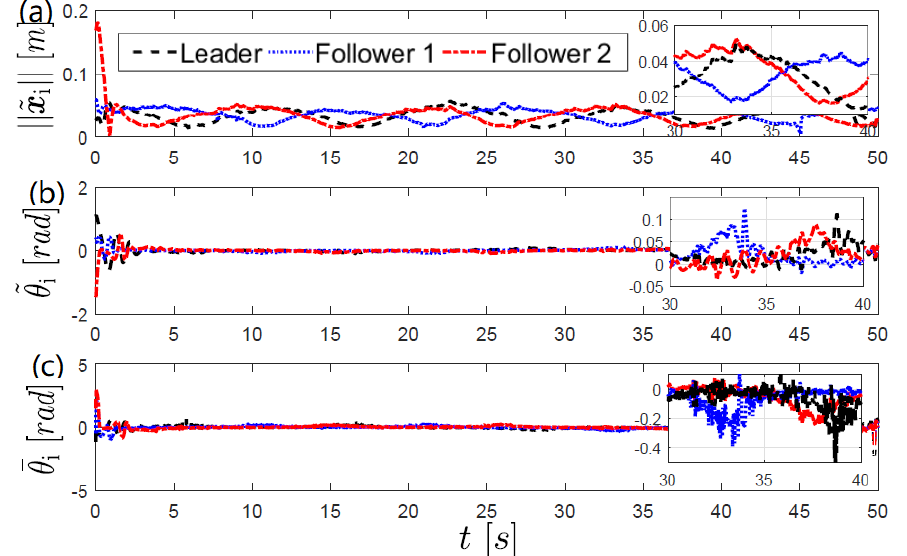
Figure 6. Time evolution of the position and attitude errors in the second experiment (lemniscate curve): ( a ) Norm of the position error (cid:101) x i , ( b ) orientation error (cid:101) θ i = θ d i − θ i , ( c ) observation error ¯ θ − (cid:98) θ i = θ i i